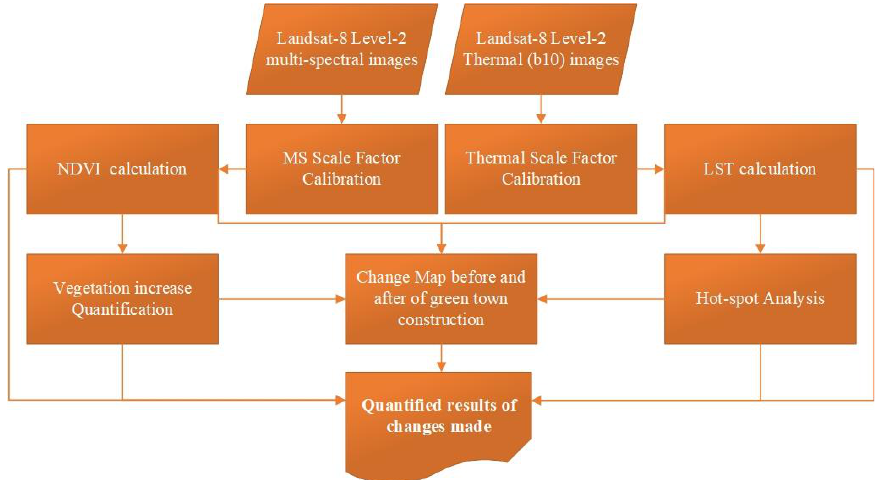
Figure 4. Flowchart of the research process of the present study.